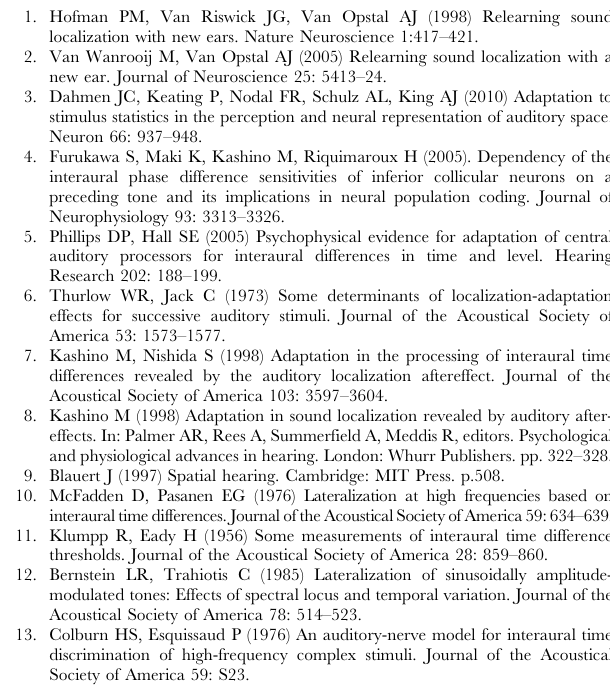
Figure S1 Proportion of ‘‘right’’ responses of each participant as a function of ITD of the test stimuli in the AM adapter condition (128-Hz modulation frequen- cy). Each row displays each participant’s result. Each column displays the results in each type of the test stimulus. See the caption of Figure 2 for explanation of abbreviations such as P128. Figure S2 Proportion of ‘‘right’’ responses of each participant as a function of ITD of the test stimuli in the tone adapter condition (128-Hz). See the caption of Figure S1 for